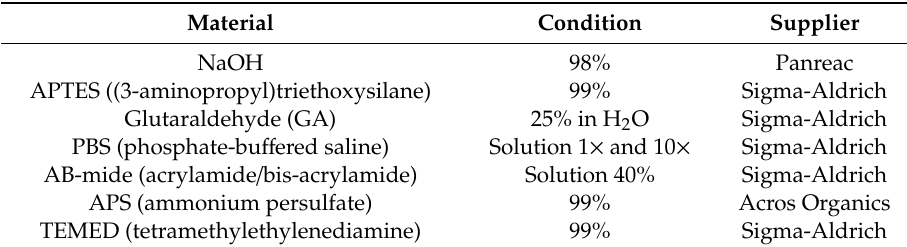
Table 1. Used materials for polyacrylamide gel synthesis. Material